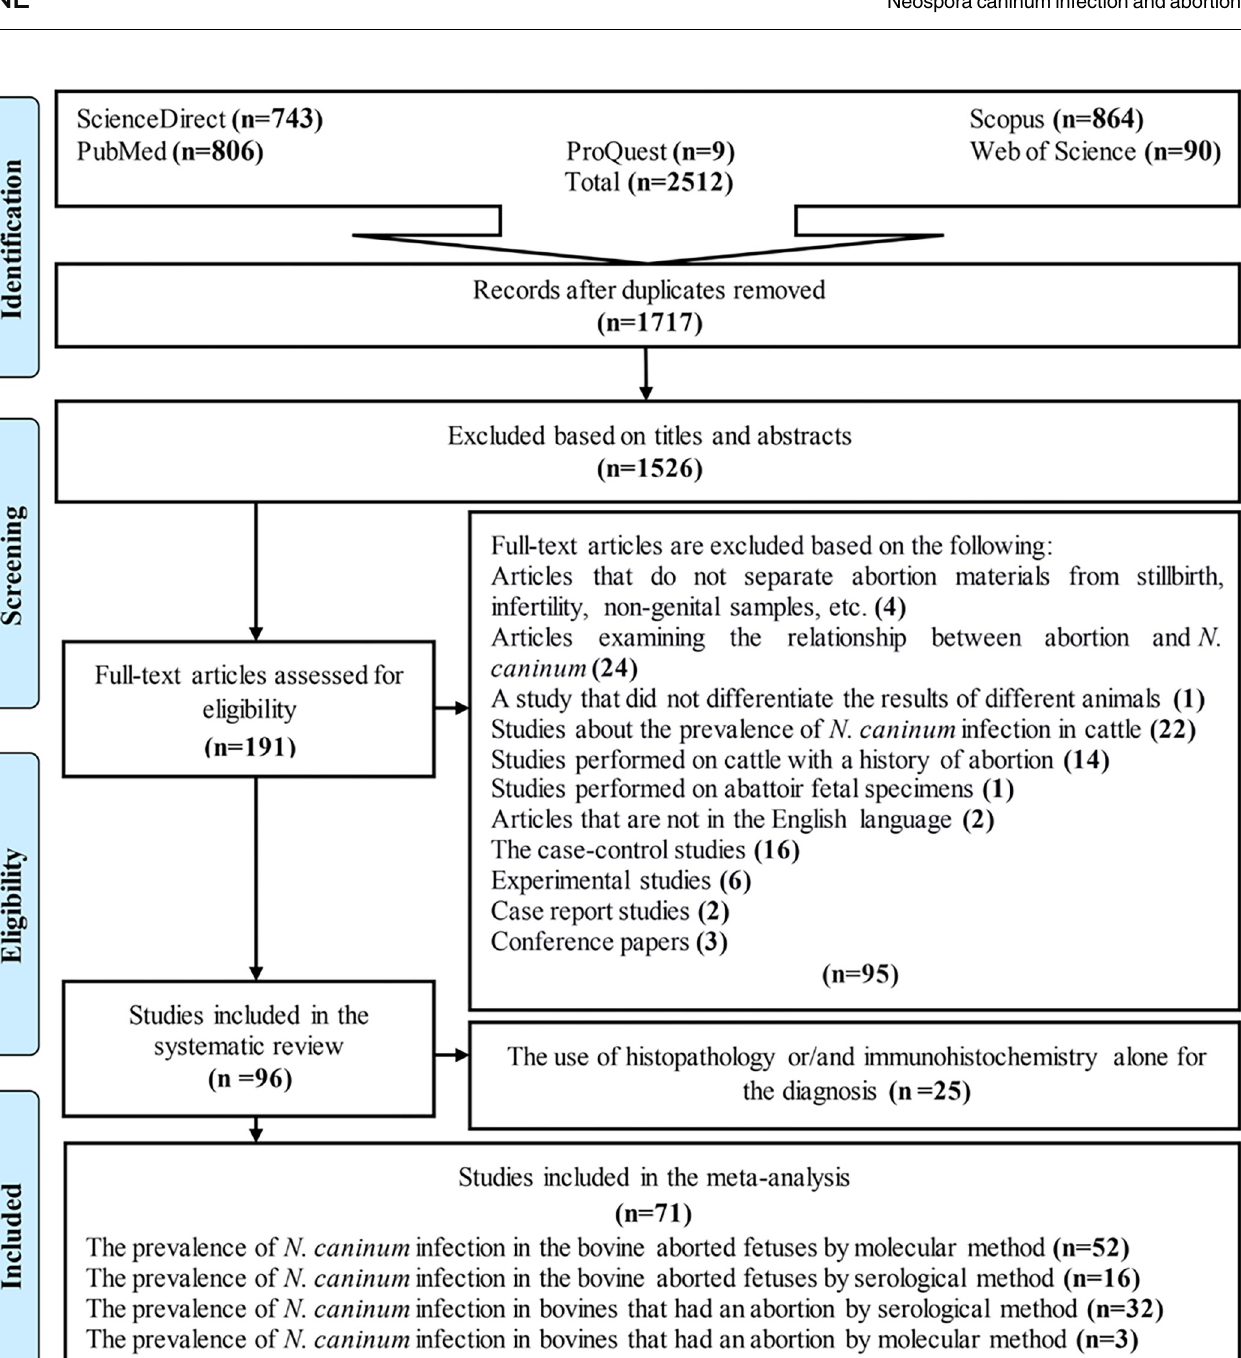
caninum in bovine aborted fetuses based on the random effect model was calculated at 35% (95% CI: 8%–62%). I-squared statistics showed a high heterogeneity among the studies (I 2 = 99.77%, p = 0.000) (Fig 3). Egger’s test was used to determine the publication bias and the results showed no publication bias on the overall prevalence estimate ( p = 0.125) (S4 Fig). Based on the meta-analysis, the prevalence of N . caninum infection in the bovine aborted